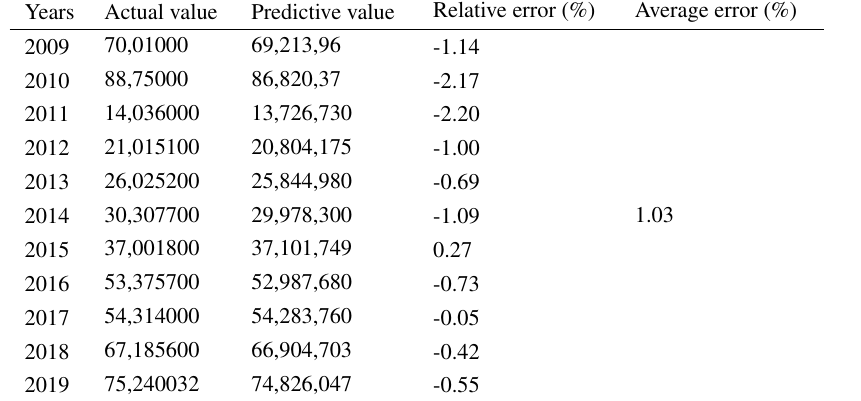
Table 3 Comparison of actual and predicted passenger flow to Lanzhou during 2009–2019 Years Actual value Predictive value Relative error (%) Average error